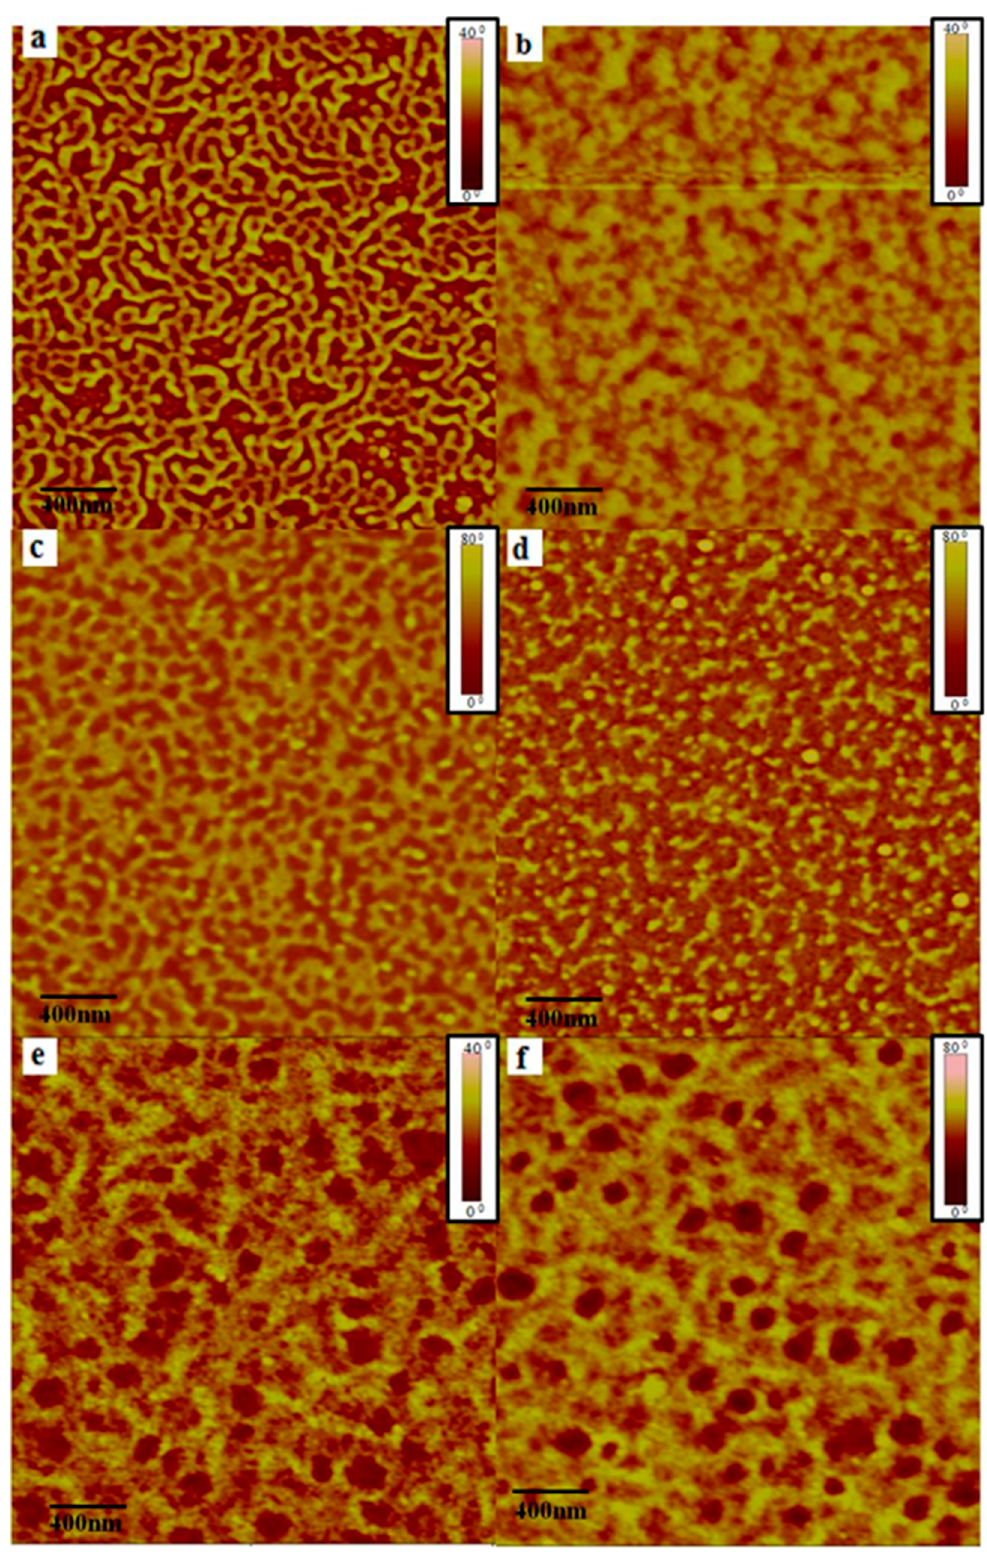
Figure 5. Phase images of thin films for sample PS 26 - b -PB 23 - b -PI 12/ PS_grafted γ -Fe 2 O 3 (10% wt.) ( a ) before exposure in benzene vapors, ( b ) after 5 h, ( c ) 25 h, ( d ) 50 h, ( e ) 72 h, and ( f ) 96 h. Scan size: 2 × 2 μ m .